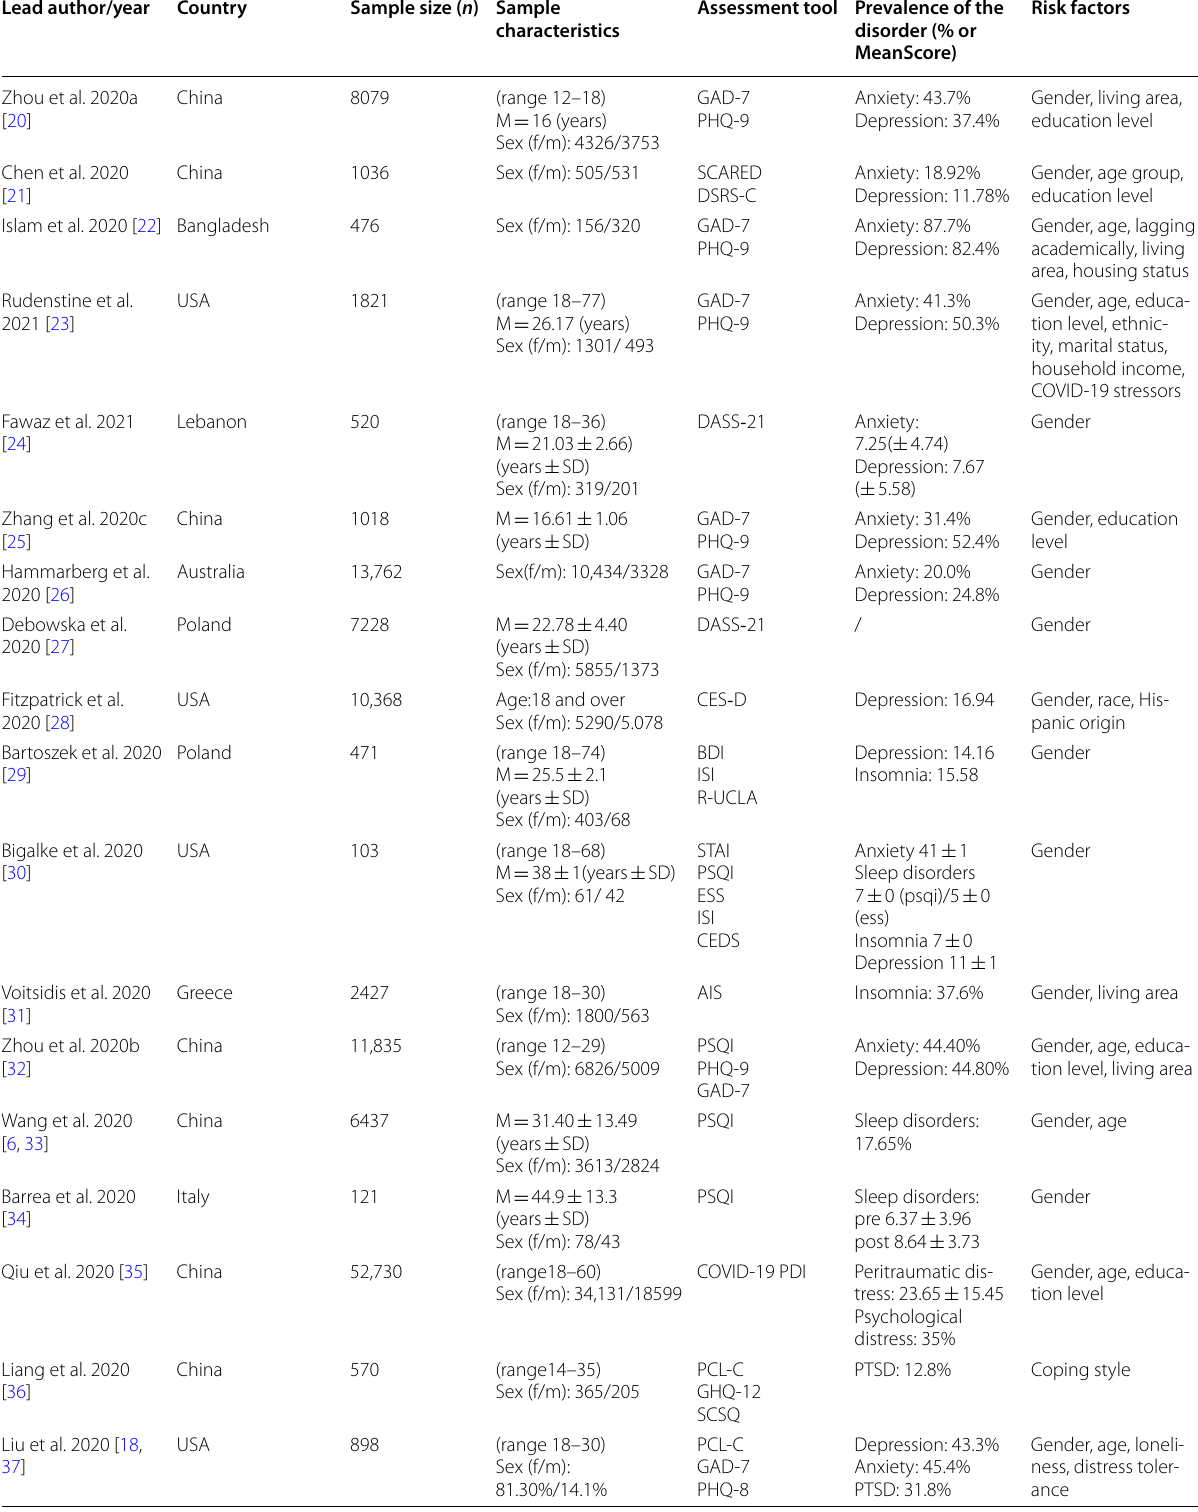
Table 1 Summary of studies, sample characteristics, assessment tools, prevalence rates, and associated risk